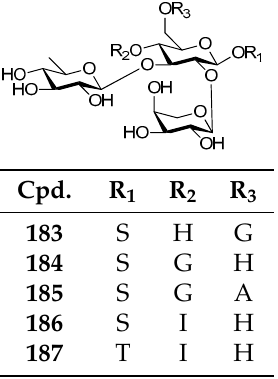
Figure 25. Structures of compounds 183 – 187 .